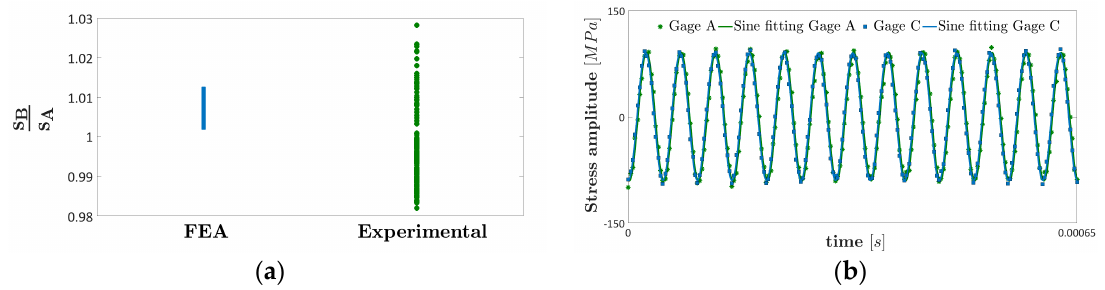
Figure 3. Validation of the stress amplitude in Gaussian specimens with very large risk-volume: ( a ) normalized stress amplitude acquired by Gages A and B and computed through FEA; ( b ) stress amplitude acquired by Gages A and